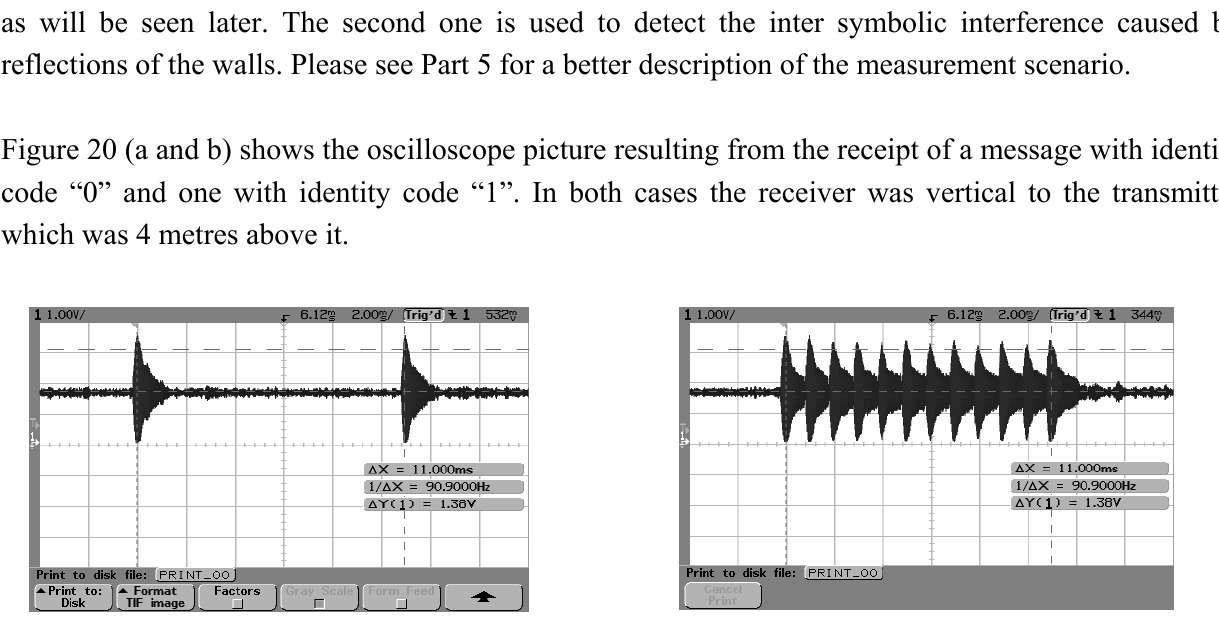
Figure 20 a and b. Received frame for ID=0 and ID=